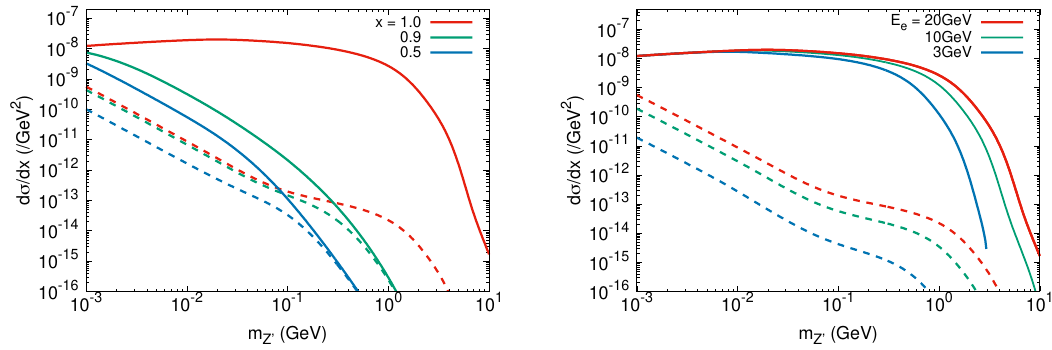
Figure 4 . The same plots as figure 2 for the vector interaction. The coupling constants are taken to be g 0 = 10 − 6 and θ = π/ 4 .